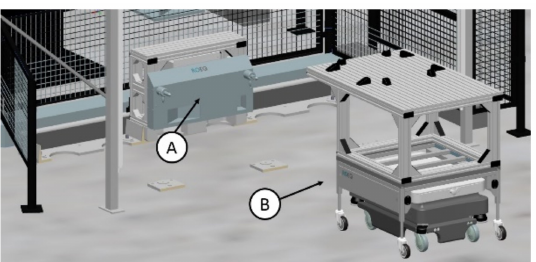
Figure 3. ( A ) A docking station module and ( B ) an AMR and a transport module. The figure is a snapshot from a simulation in